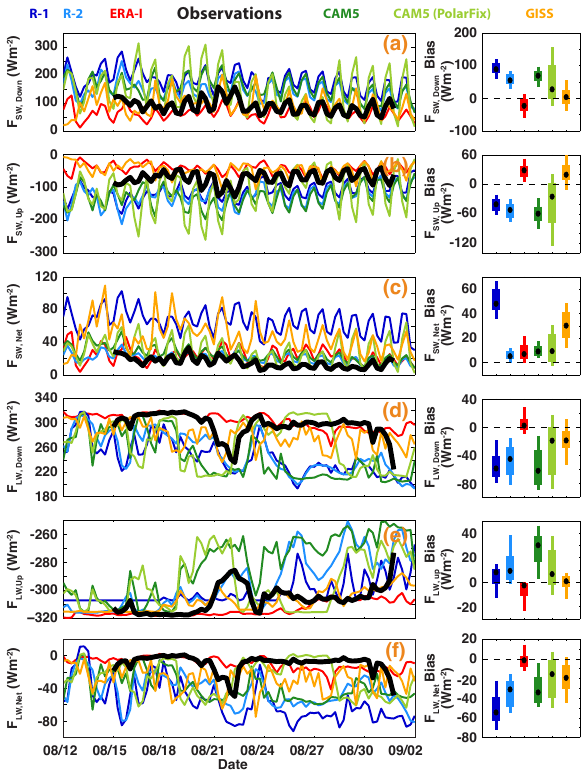
Fig. 4. Time series of surface energy budget terms (from top to bottom: average downwelling shortwave flux density, average up- welling shortwave flux density, average net shortwave flux den- sity, average downwelling longwave flux density, average upwelling longwave flux density, average net longwave flux density). Included are lines for the observations from Oden (bold black line), CAM5 (standard version, dark green; CAM5-PF, light green), the GISS- ModelE2 (orange), and R-1 (dark blue), R-2 (light blue) and ERA- I (red) reanalyses. All lines represent six-hour average values. The right-hand side of the figure includes distributions depicting the me- dian (black dot), IQR (wide bar) and 10th–90th percentiles (thin bar) of the differences between simulated and observed